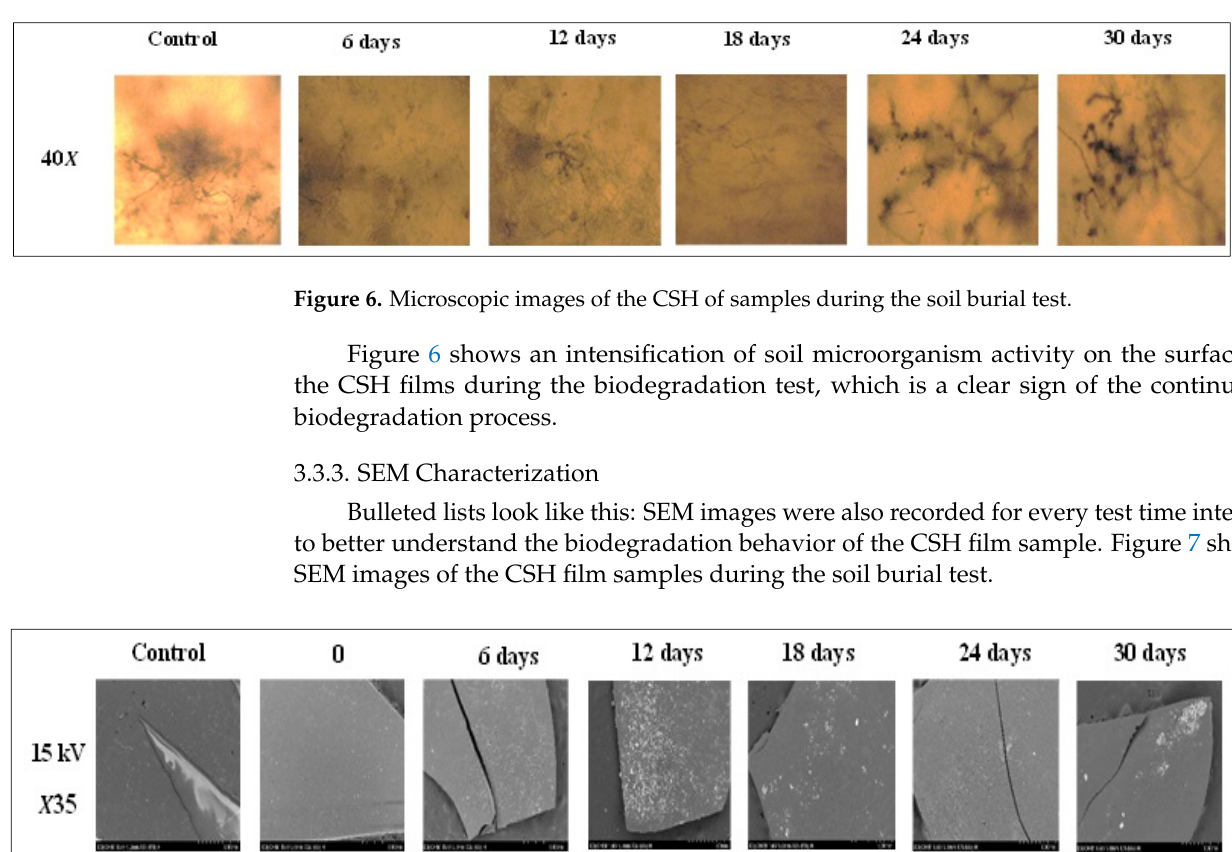
Figure 5. The physical appearance of CSH film samples and control samples before ( a ) and during ( b ) the soil burial test.